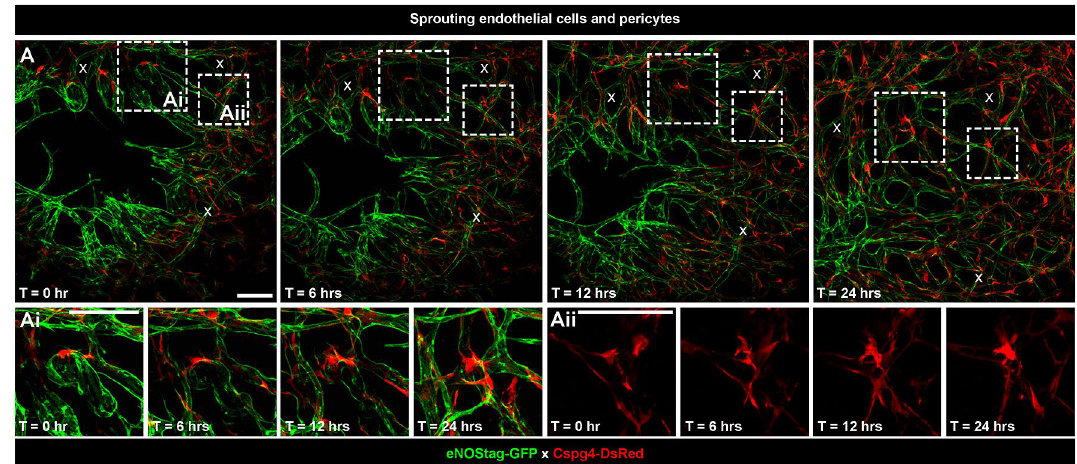
Figure 7. High resolution 4D intravital imaging of sprouting endothelial cells and pericytes. ( A ) Representative 70 µm subsequential maximal projections of endothelial cells (eNOStag-GFP in green) and pericytes (Cspg4- DsRed in red) in a B16BL6 melanoma tumor. ( Ai , Aii ) Zoom-in showing endothelial cell and pericyte spatial and temporal dynamics. x represents reference points in the vasculature. Scale bar represent 100